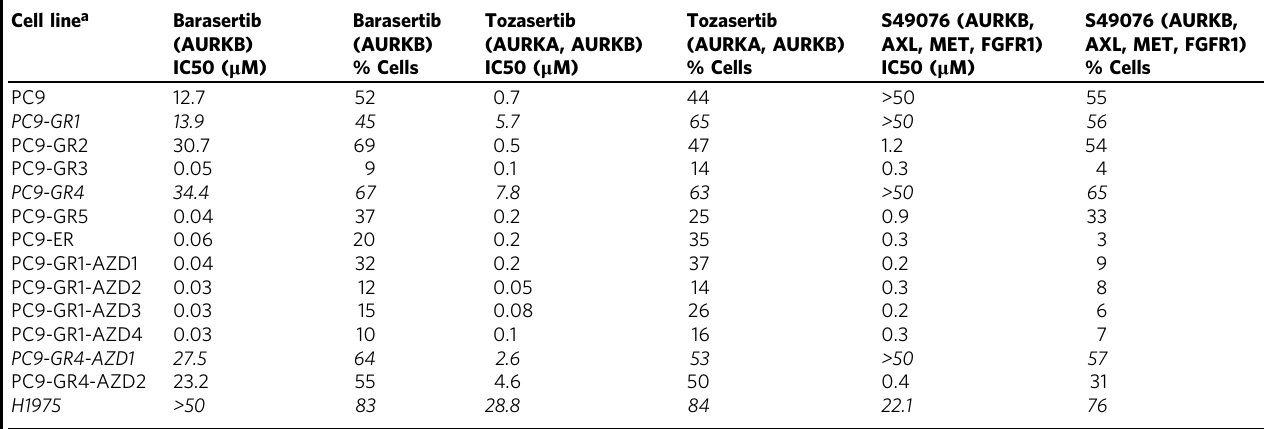
Table 2 Sensitivity to Aurora inhibitors of the PC9-derived cell lines used in the study Cell line